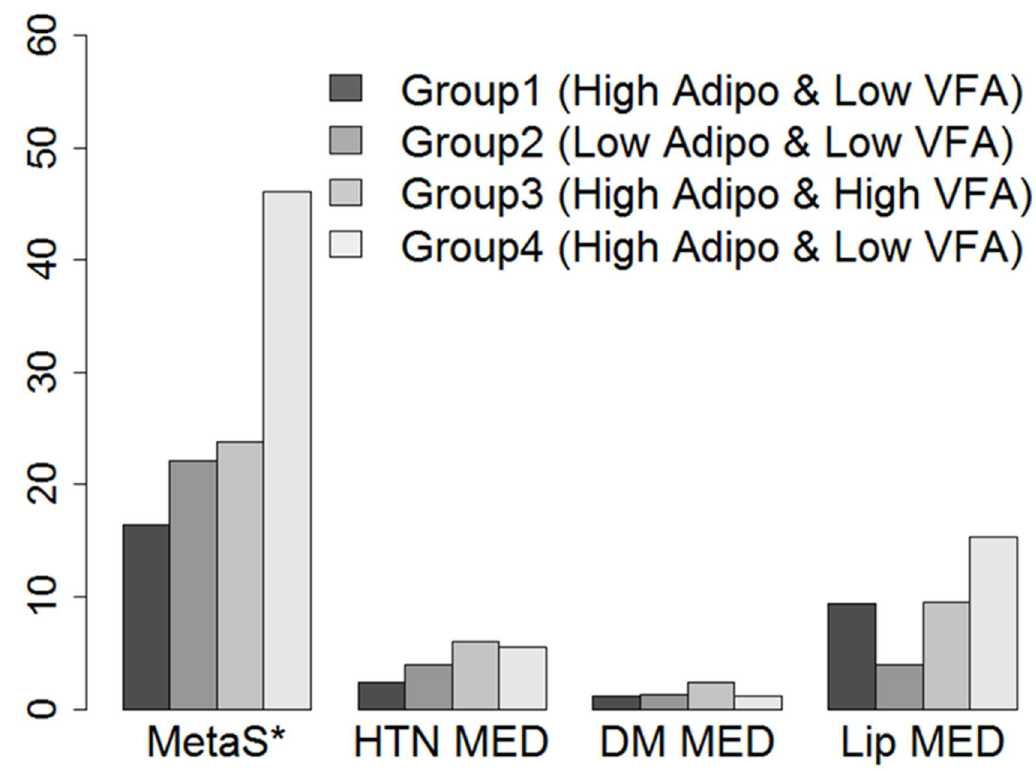
Fig 2. Incidence of metabolic syndrome at follow-up. Adipo, Serum adiponectin level; VFA, Visceralfat area; MetaS, Metabolicsyndrome; HTN MED, Antihypertensive Medication; DM MED, AntidiabeticMedication; Lip MED, AntihyperlipidemicMedication. * Result of comparisonbetweenGroups, p <